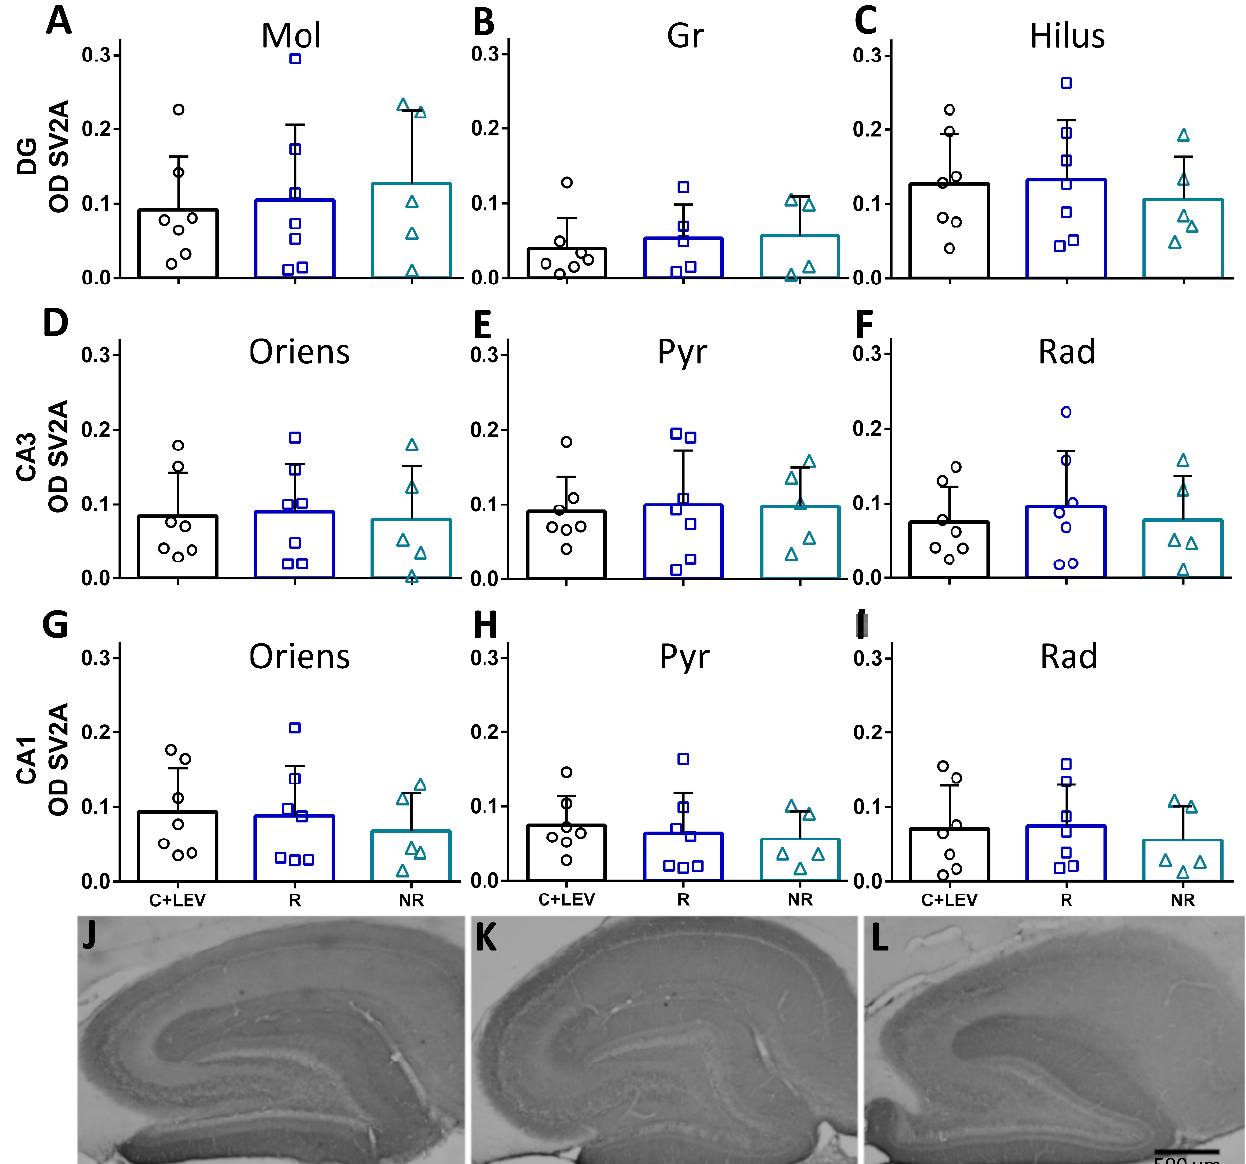
Figure 3. SV2A optical density (OD) after calibration and background subtraction. ( A – C ) Graphs of SV2A OD in the dentate gyrus (DG). ( D – F ) Graphs of SV2A OD in the CA3. ( G – I ) Graphs of SV2A OD in the CA1. The data are shown as mean ± SD ( J – L ). Representative microphotographs of SV2A OD in C+LEV ( J ), R ( K ), and NR ( L ) rats (scale bar = 500 µm).